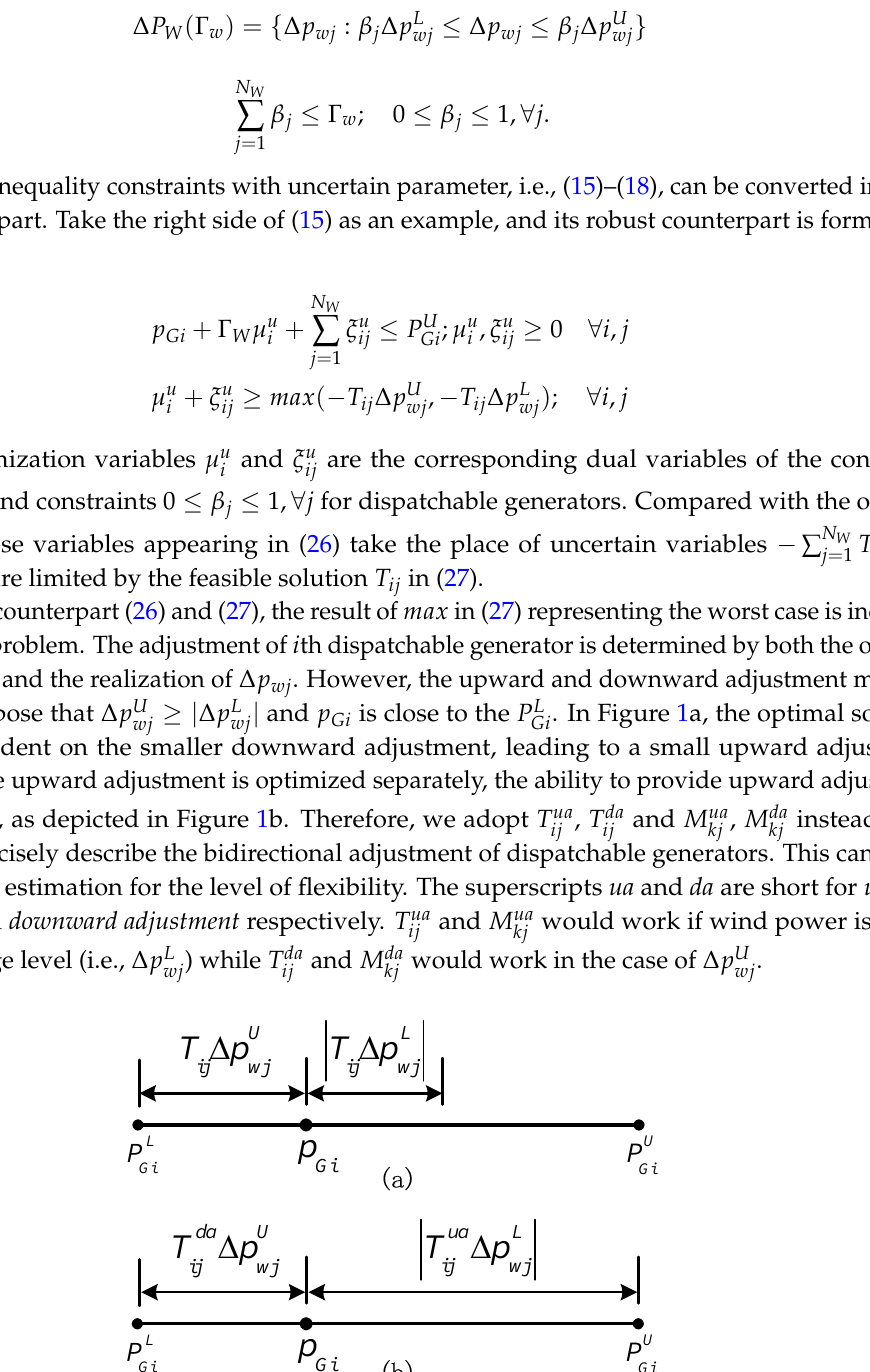
and T da , to optimize the upward and downward ij ij